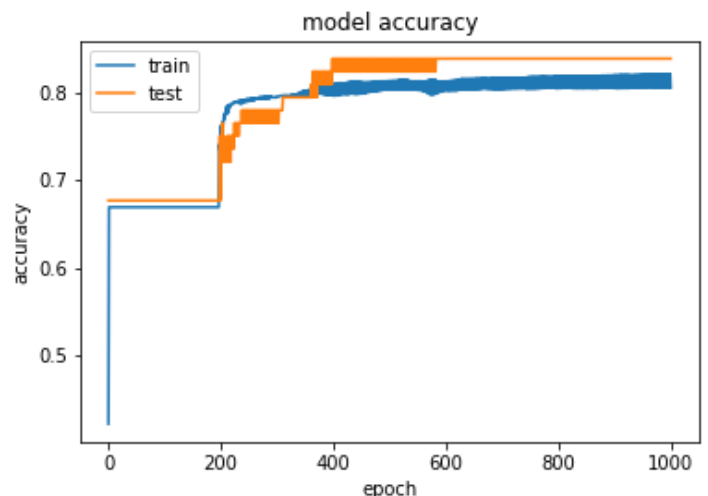
Figure 12. LSTM-AR- results (training dataset = 80%, testing dataset = 20%): Model Accuracy versus epochs.